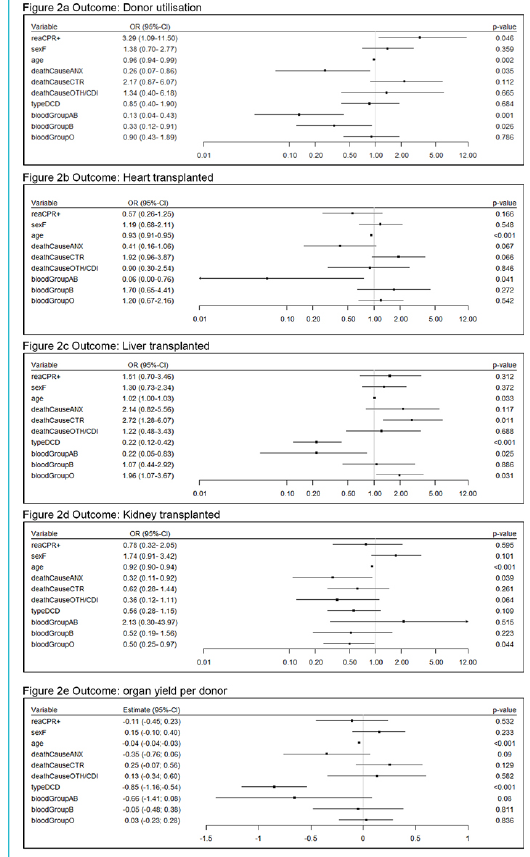
Figure 2a-e: Odds ratios (a-d), and estimates (e), with 95% confi- dence intervals of five multivariable regression analyses. Logistic regression of the outcome donor utilisation (a), heart (b), liver (c), and kidneys transplanted (d). Linear regression of the total number of transplanted organs per donor (e). For the variables cause of death and blood group, odds ratios and estimates to the reference cerebral haemorrhage (CHE), and blood group A are given. In the case of the continuous variable age, odds ratios and the estimate correspond to an increase of 1 year. Of note: the variable year of admission/death was included in all regression models but, for rea- sons of space, is not displayed. ANX = anoxia; CDI = cerebral dis- ease; CPR = cardiopulmonary resuscitation; CTR = cerebral trau- ma; DCD = donation after cardiocirculatory death; OTH =